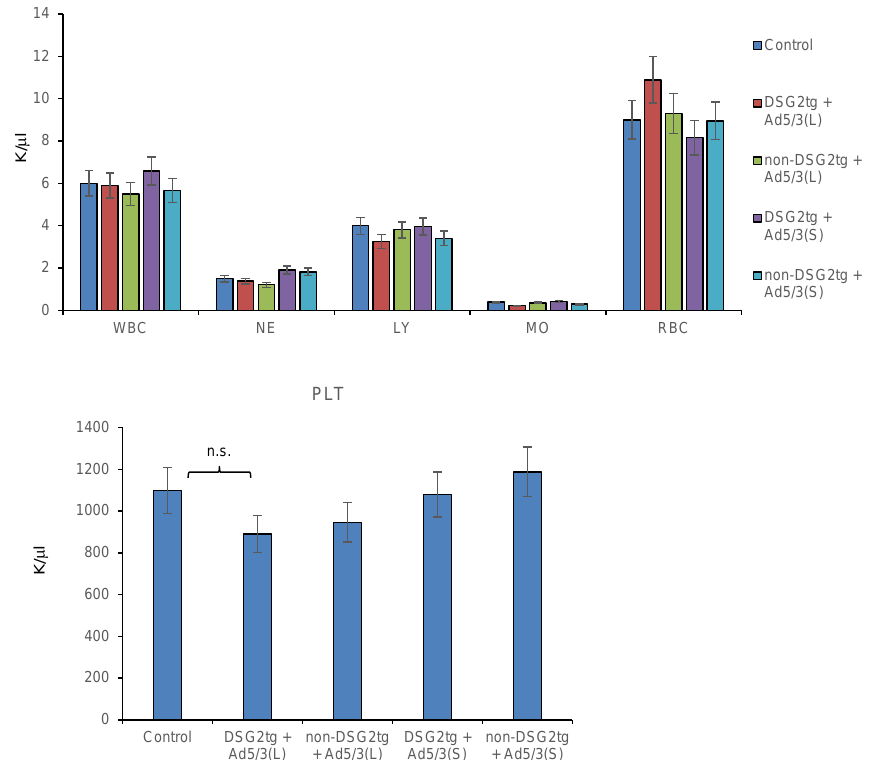
Figure 8. Hematological analyses of Ad5/3-luc injected mice. Blood samples were analyzed on day 3 after virus injection. Shown are data for tumor-bearing DSG2-transgenic and non-transgenic mice injected with the two Ad5/3-luc vectors. n = 3, * p <0.05. WBC – white blood cells, NE – neutrophils, LY – lymphocytes, MO – monocytes, RBC – red blood cells. Platelet (PLT) counts are shown in the lower panel.